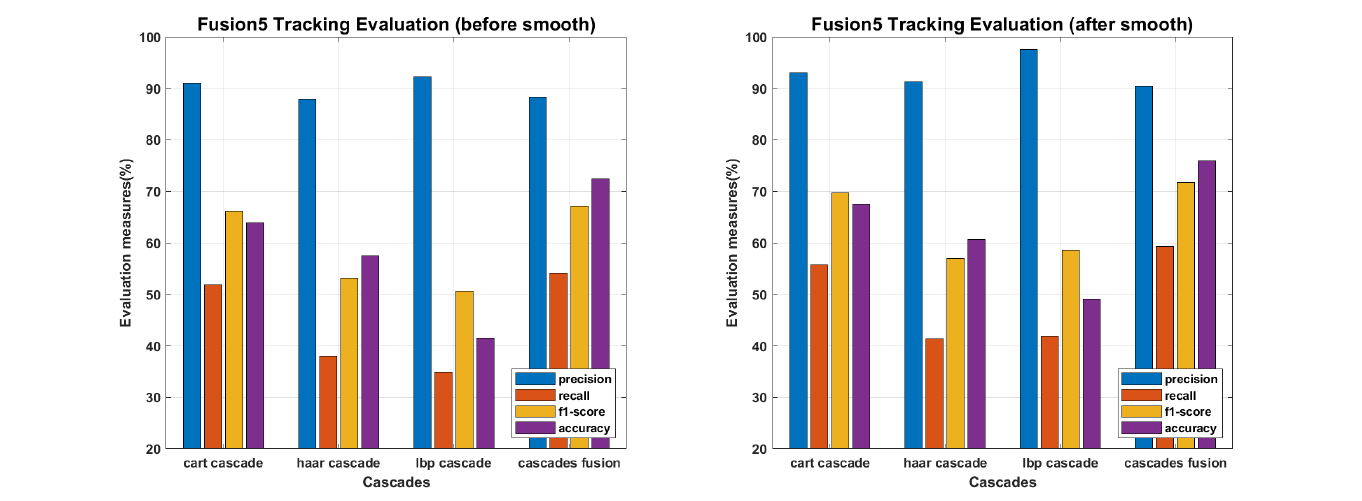
Figure 20. Tracking Evaluation for fusion of all recognition cascades through soft-voting scheme. The overall f1-score and accuracy rate of cascade fusion is 67.1083% and 72.4924% (before smoothing) and 71.644% and 75.9249% (after smoothing)